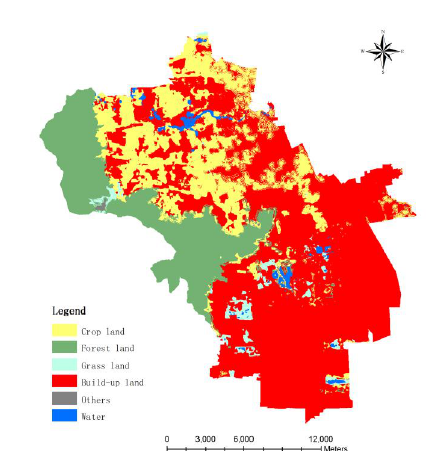
Figure. 11 spatial distribution of prediction land cover in 2015, Haidian District